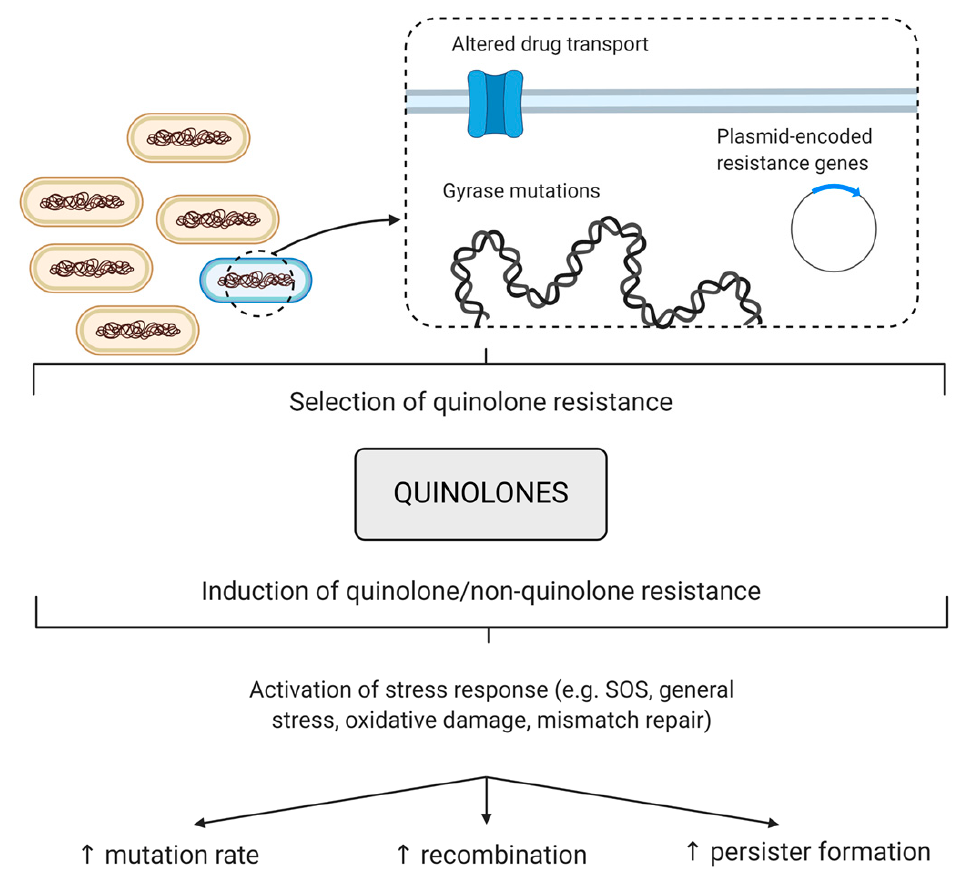
Figure 7. Contributions of quinolones to antibiotic resistance. Quinolones can select for quinolone resistance, which is caused by the upregulation of efflux pumps, mutations in DNA gyrase or DNA topoisomerase IV genes or plasmid-encoded resistance genes. Quinolones can also induce resistance to quinolones and non-quinolones antibiotics, presumably by the activation of a stress response that then increases the mutation, recombination or persister formation rates.